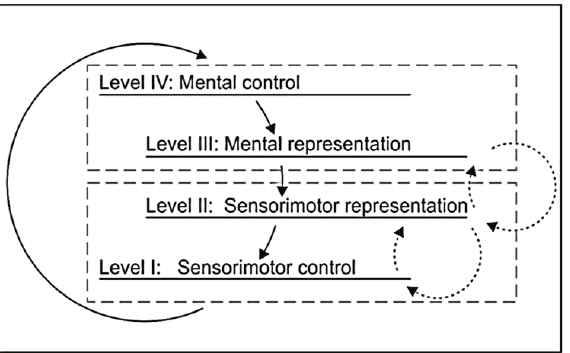
Figure 5. Levels of hierarchical action organization of motor actions. Adapted from Schack [21], reprinted from Kim et al.